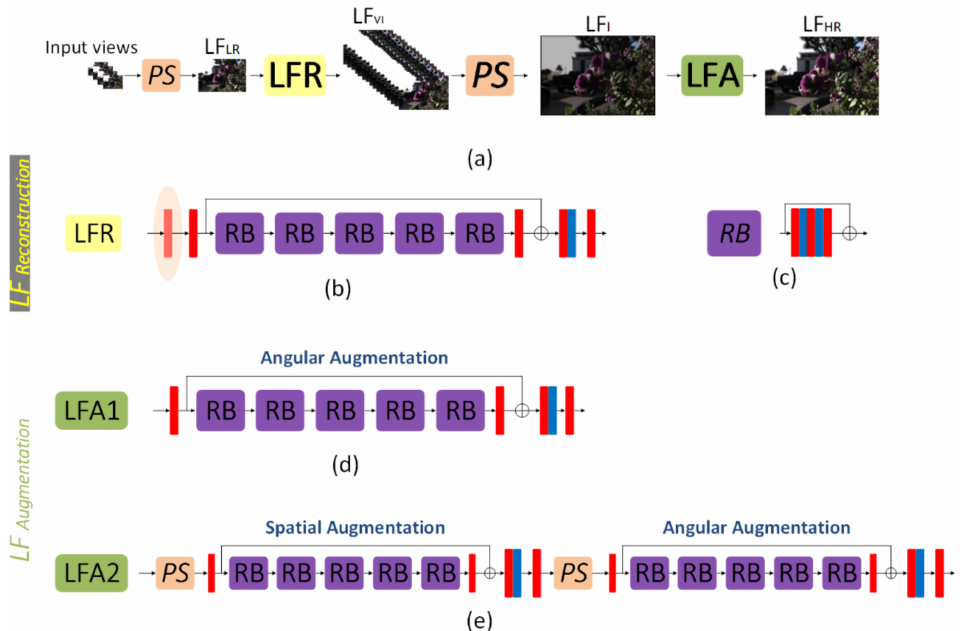
Figure 4. A visual representation of the proposed network architecture. ( a ) The sparse set of input views are rearranged into raw LF representation LF LR using the periodic shuffling operator (PS) to reconstruct the input raw LF image, and this image is then fed into the LF reconstruction block (LFR) to generate the initial LF images LF VI . These images are then rearranged into the raw LF representation using the PS. The initial raw LF image LF I is fed into the LF augmentation block (LFA) to improve the quality and generate the final high-resolution image LF HR . ( b ) (LFR): this block is responsible for reconstructing dense LF images from a few input images. It can be called a magnifier where the magnification percentage depends on the reconstruction task (number of input images and the number of images to be reconstructed). ( c ) The residual block (RB) is the network’s central unit, consisting of cascaded convolutions and ReLU connected by a skip connection, where the red block represents the convolutional layer (Conv). In contrast, the blue ones represent the rectified linear unit (ReLU). ( d ) (LFA1): this block is responsible for enhancing the quality of the initial reconstructed LF images. It consists of one block that works on the raw LF images to perform an angular augmentation. ( e ) (LFA2): this block performs the same function as the LFA1 block; however, the first main block here works on the view stack images to perform a spatial augmentation rather than working on the raw LF images to perform an angular augmentation. Where LFA1 is used for the extrapolation tasks (task 2: 2 × 2 − 8 × 8 extrapolation 1, and task 3: 2 × 2 − 8 × 8 extrapolation 2.), while LFA2 is used for the interpolation task (task 1: 2 × 2 − 8 × 8 Extrapolation 0) as shown in Figure